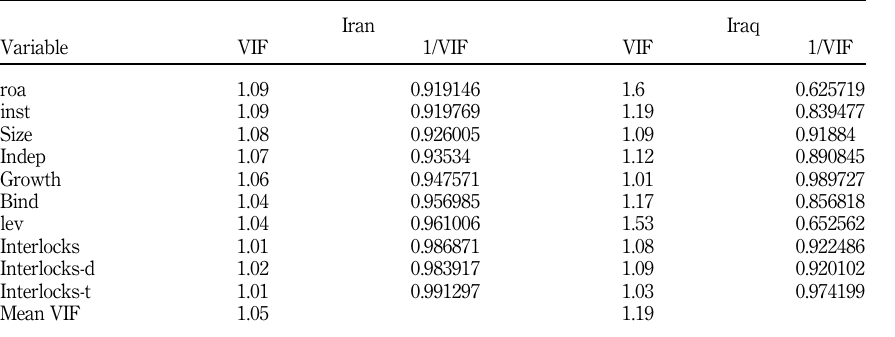
Table 2. The results of